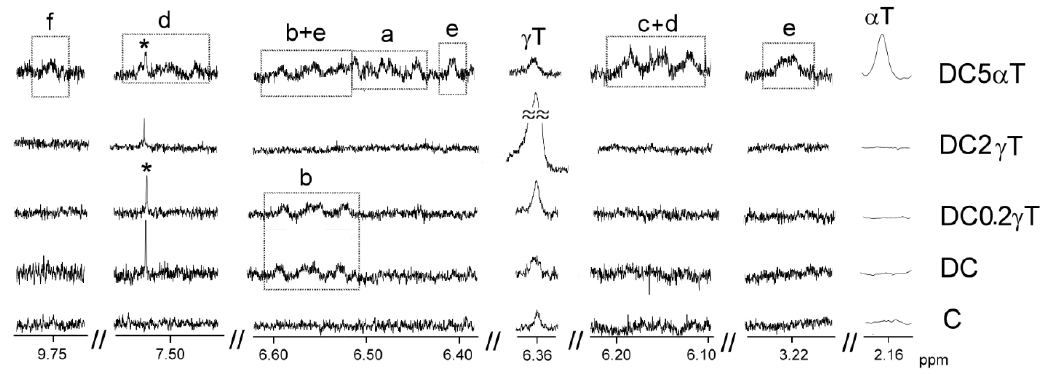
Figure 2. Some regions of the 1 H NMR spectra of oil C and of the lipids extracted from the digestates of some enriched in tocopherol samples, conveniently enlarged, where signals of protons belonging to oxidation compounds and to gamma - and to alpha -tocopherol appear. The signal letters agree with those of Tables S4 and S5. The singlet marked with * is a satellite peak of chloroform.